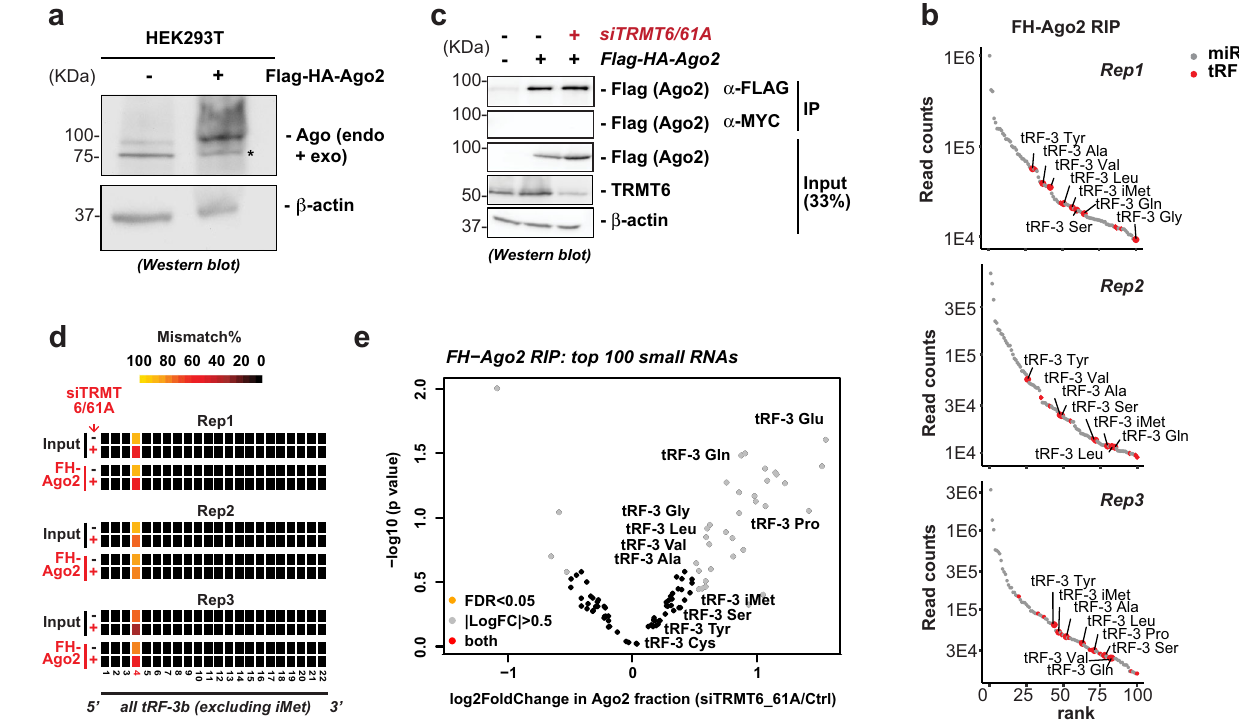
Fig. 5 Argonaute association of tRF-3b is not decreased by TRMT6/61A-dependent m 1 A. a Construction of stable FH-Ago2 cells, detected by anti-pan- Ago western blot (*indicates non-speci fi c band detected by the antibody). The pan-Ago band detects both endogenous Ago proteins and tagged FH-Ago2 protein. b Top 100 ranking small RNAs (gray dots: microRNAs, red dots: tRFs) detected in Ago2 RIP (RNA immunoprecipitation) are plotted ( Y -axis: read counts on log10 scale). c Ago2 RIP was performed in HEK293T siCtrl and siTRMT6/61A. d TGIRT-seq of the Ago2-bound and input fractions identi fi ed lower m 1 A mismatch on tRF-3b. The color-shaded mismatch rate was calculated for all tRF-3b excluding the one from tRNA iMet . e Volcano plot of the Ago2-bound small RNA changes upon siTRMT6/61A (differential analysis and p value by DESeq2 Wald test). Data in this fi gure are based on TGIRT-seq of three independent Ago2 RIP experiments in HEK293T stable Flag-HA-Ago2 cells. See also Supplementary Fig. 4 and Supplementary Table 3. Source data are provided as a Source Data fi